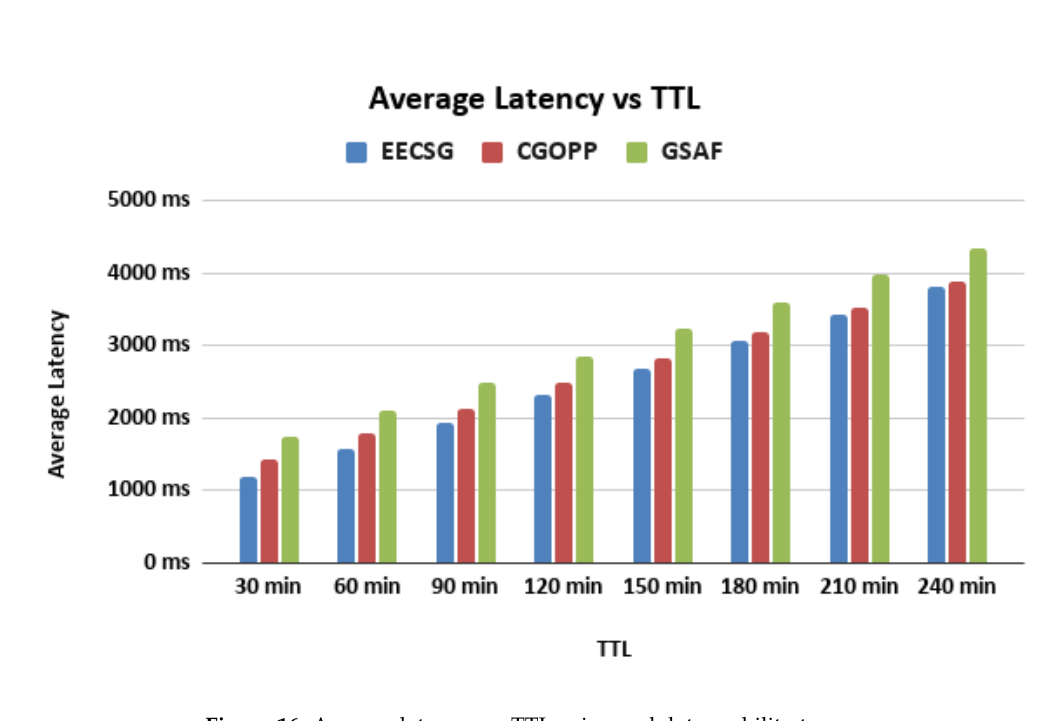
Figure 16. Average latency vs. TTL using real data mobility traces.